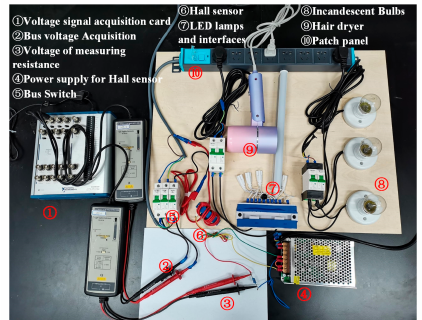
Figure 8. NILM experimental